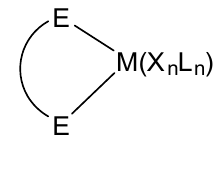
Figure 1. Chelate coordination and cyclometalated complexes.